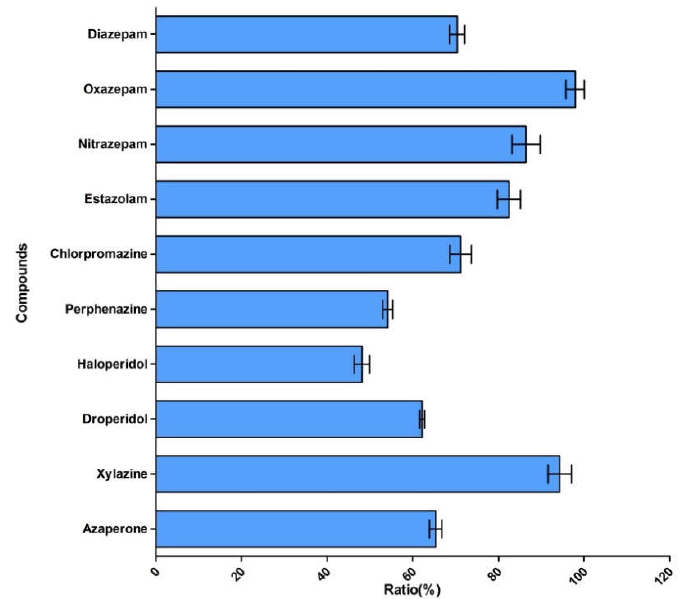
Figure 3. Ratio of matrix-matched standard versus standard in pure solvent.